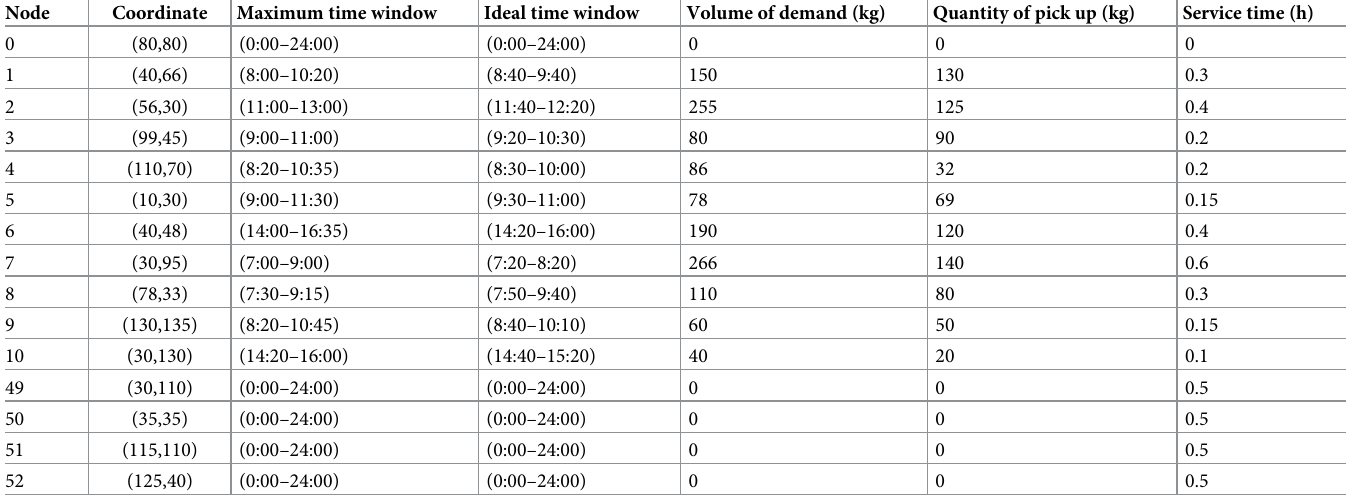
500, the crossover probability is 0.8, and the mutation probability is 0.2. Table 3. Logistics distribution information and